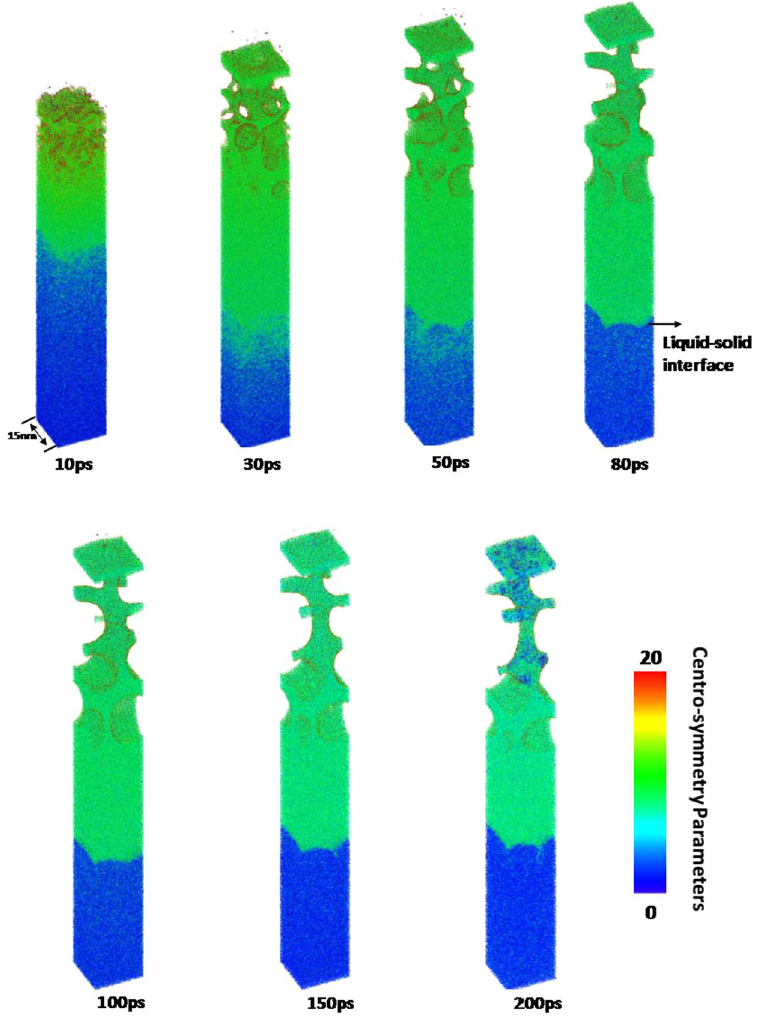
Figure 9. Snapshots of atomic configuration in the 0–100 nm part of 450 nm 〈 100 〉 copper film under an absorbed laser intensity of 0.065 J/cm 2 at 10–200 ps time instant. The atoms are colored according to their centro-symmetry parameters.